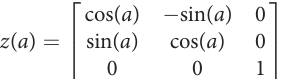
FIGURE 1 Wrist lateral view of a healthy Normal radius which showed dorsal tilt.